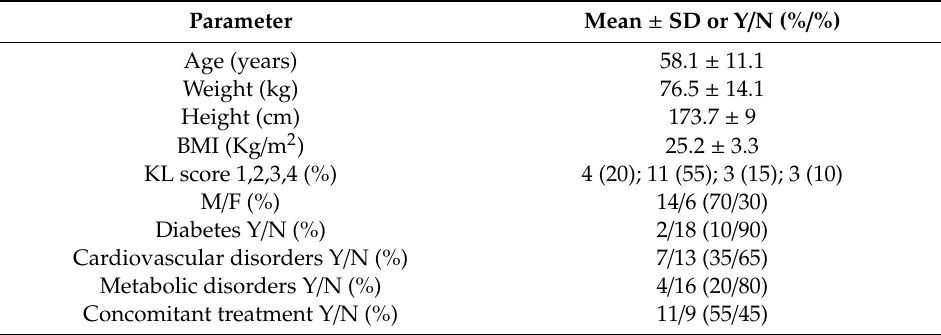
Table 3. Patient characteristics at baseline.